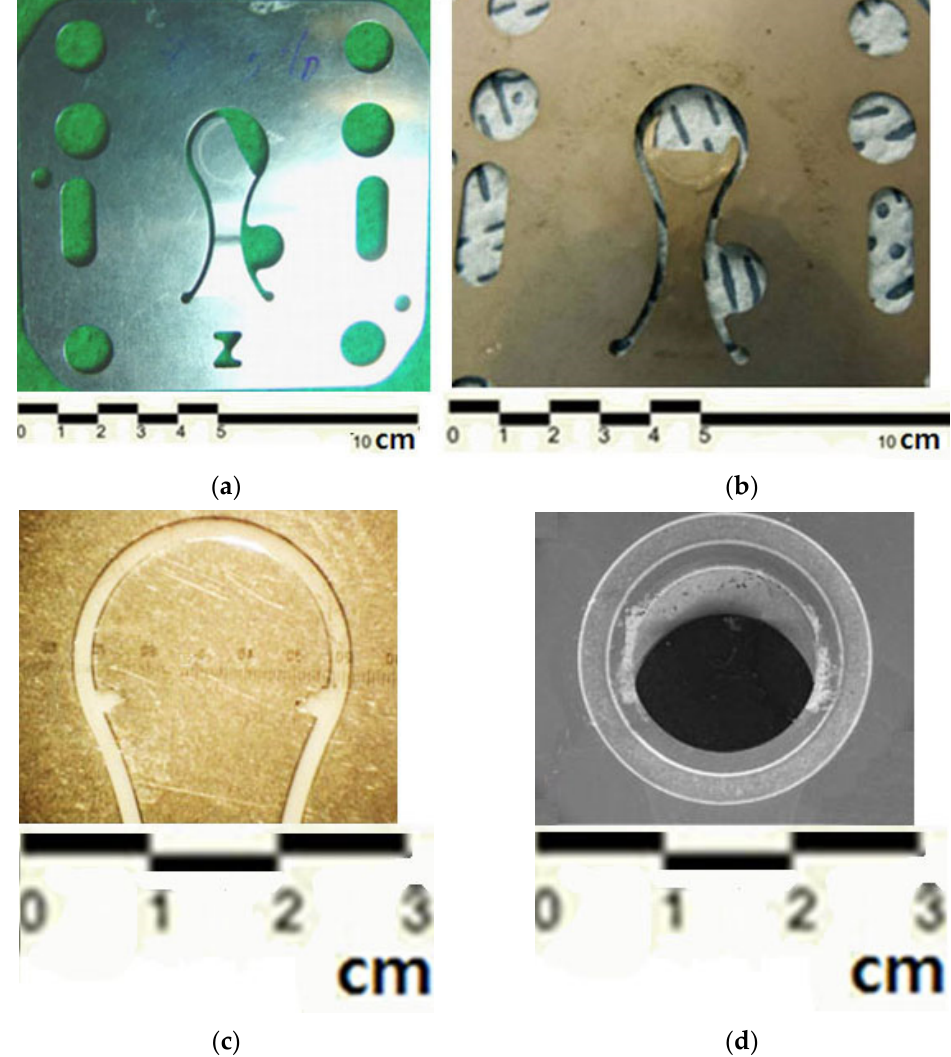
Figure 10. Failed suction reed valves from the field and first ALT: ( a ) failed products from the field, ( b ) outcome after first parametric ALT, ( c ) partially broken suction reed valve from the first ALT, ( d ) shattered valve plate.